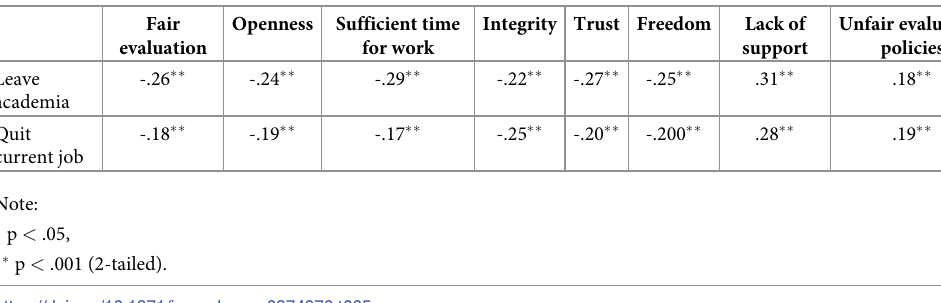
Table 5. Spearman correlations for research climate items and leave/quit considerations.